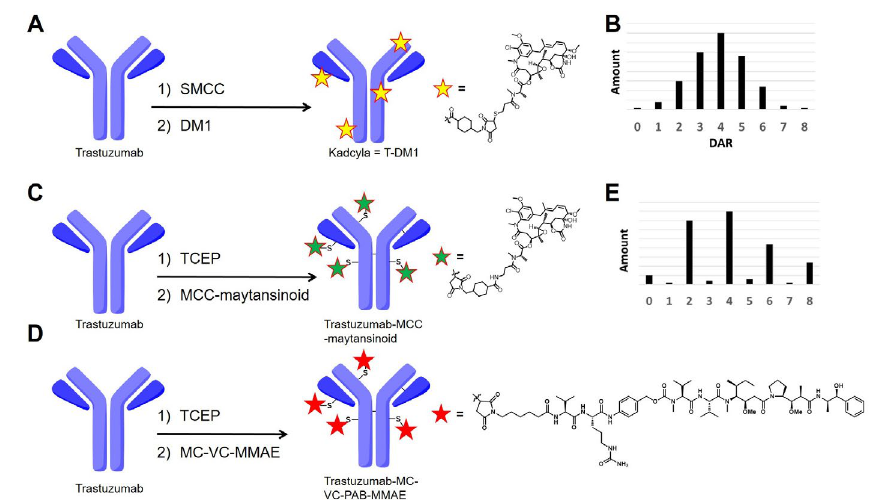
Figure 1. Summary of conjugation chemistry to produce ADCs. A. Native lysine conjugation to synthesize T-DM1 (kadcyla); B. DAR distribution of lysine-based ADCs; C. native cysteine conjugation to synthesize trastuzumab-MCC-maytansinoid; D. native cysteine conjugation to synthesize trastuzumab-(MC)-(VC)-MMAE; E. DAR distribution of cysteine-based ADCs. SMCC: succinimidyl-4-( N -maleimidomethyl)cyclohexane-1-carboxylate; TCEP: Tris(2-carboxyethyl)phosphine; MC: maleimidocaproyl; VC: valine-citrulline; MCC: ( N -maleimidomethyl)cyclohexane-1-carboxylate; PAB: p-aminobenzoyloxycarbonyl; MMAE: monomethyl auristatin-E; DAR: drug-to-antibody